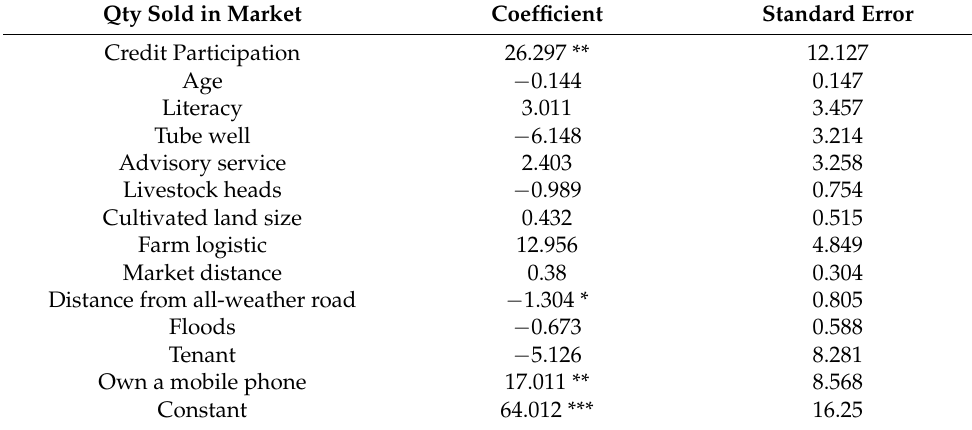
Table A6. Full table of IV estimate of second-period credit and market